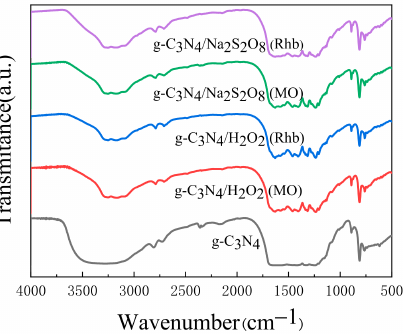
Figure 11. The FT-IR of synergetic system before and after degradation.